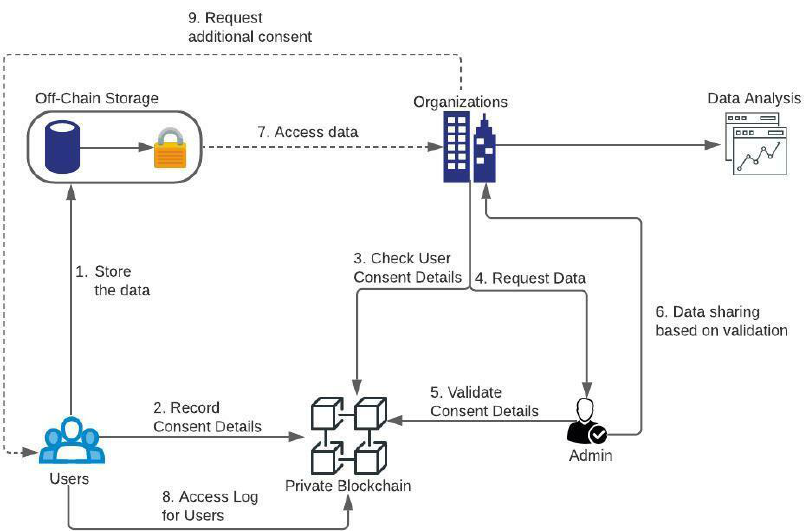
Figure 2. The proposed solution’s system architecture.